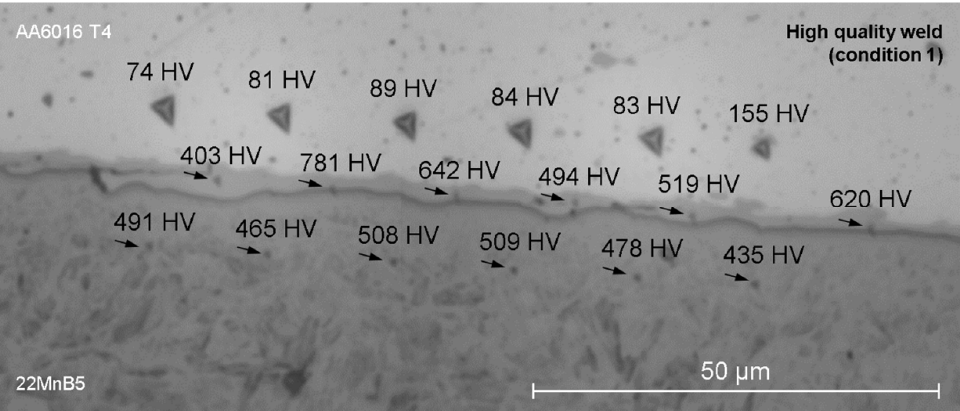
Figure 13. Nanoindentation results of the interfacial area of an Al/steel joint (high-quality weld, indentation force 5 mN).